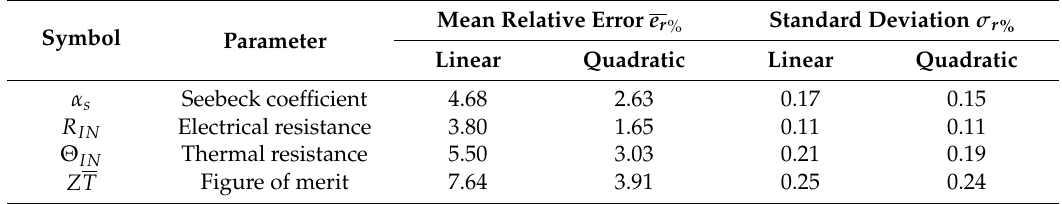
Table 2. Relative Error of the CS method with linear and quadratic fit with respect to SS method. Symbol